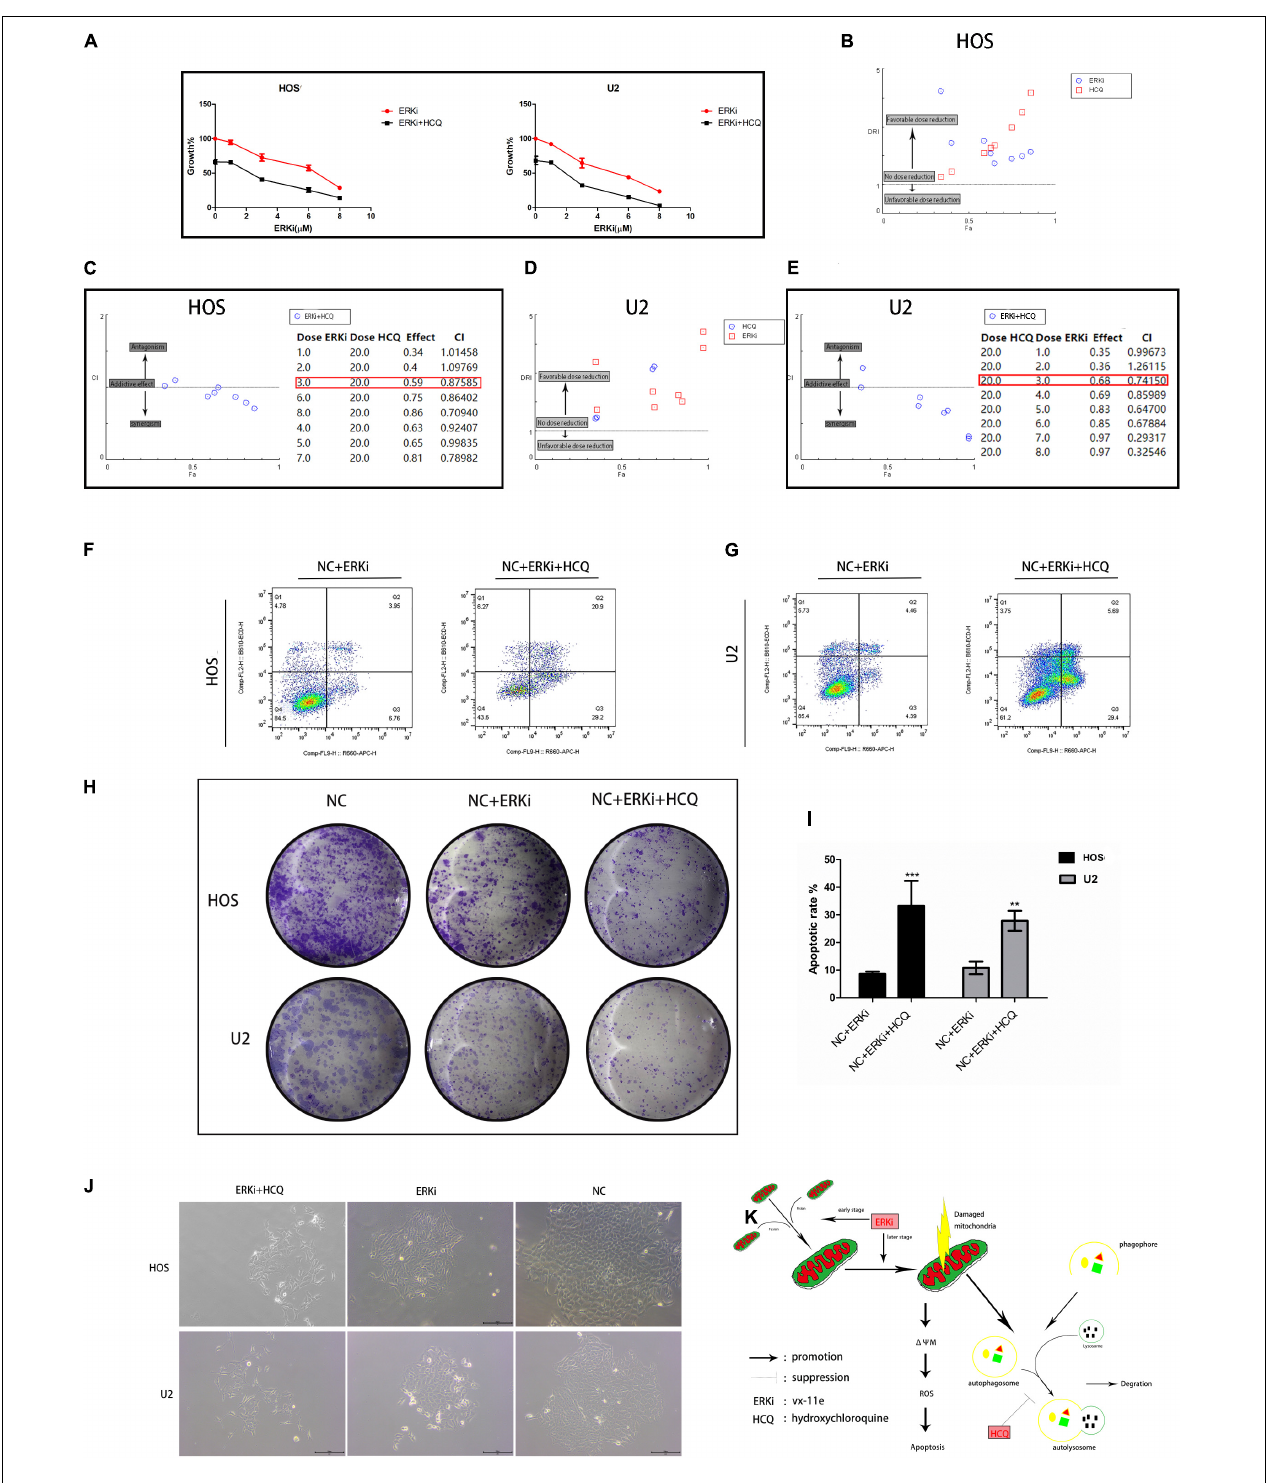
FIGURE 6 | Synergistic inhibitory effect of ERKi and HCQ combined treatment on OS cell activity. (A ) OS cells were treated with ERKi and HCQ (20 µ M) for 24 h. Proliferation was assessed using live-cell counting. ( B,D ) Dose reduction index (DRI) for each drug for a given effect (Fa). DRI of > 1, 1, and < 1 indicate a favorable dose reduction, no dose reduction, and a negative dose reduction, respectively. (C,E) Combination index (CI) values as a function of the effect levels (Fa), where CI values of > 1, 1, and < 1 indicate synergism, an additive effect, and antagonism, respectively. (F,G,I) Flow cytometry to determine the percentage of total apoptotic OS cells. (H,J) Colony-forming assay for OS cells. (K) Schematic representation of the synergistic effects of ERKi and HCQ on OS cells (n = 5 per group; *** p < 0.001 versus NC + ERKi group; ** p < 0.01 versus NC group).